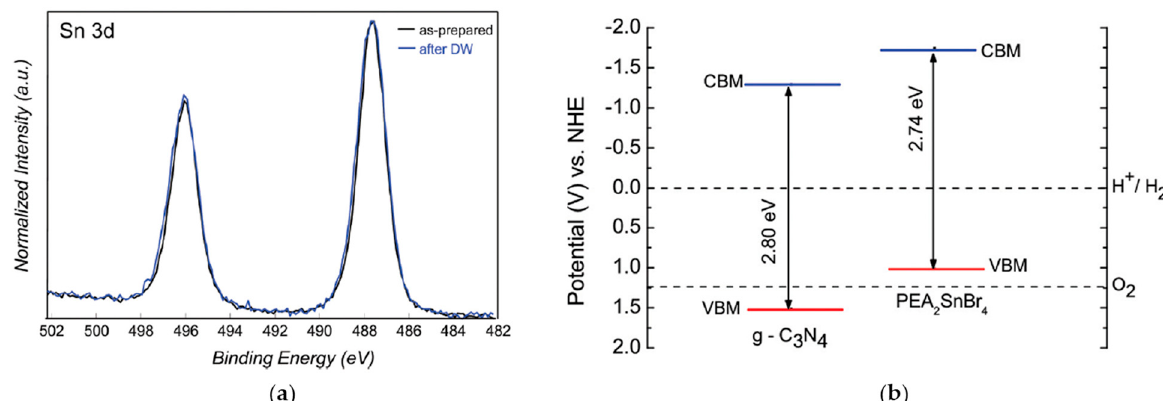
Figure 5. ( a ) Sn 3d high-resolution X-ray photoelectron spectroscopy (XPS) spectra of the as-prepared PEA 2 SnBr 4 and after storage in water; ( b ) Calculated band edge positions (continuous lines) for g-C 3 N 4 and PEA 2 SnBr 4 relative to Normal Hydrogen Electrode (NHE) potential; the dashed lines indicate the water redox reaction potentials. Reproduced with permission [16] Copyright 2020, Royal Society of Chemistry.